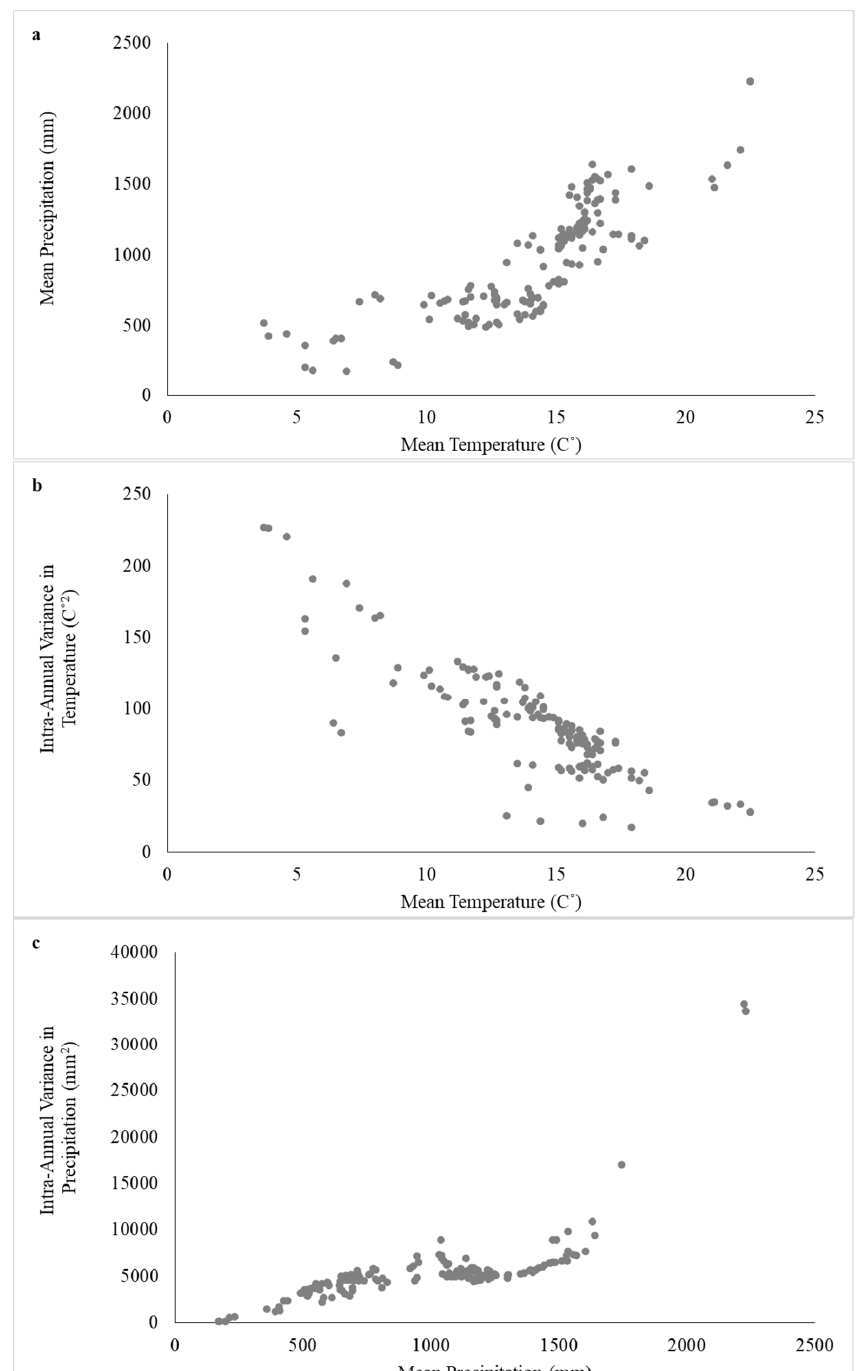
Figure 1. Relationship between historical climate variables in the dataset. ( a ) Annual average temperature and precipitation levels for each wastewater treatment plant in the sample; ( b ) Annual average temperature levels and intra-annual variation in temperature for each wastewater treatment plant in the sample; ( c ) Annual average precipitation levels and intra-annual variation in precipitation for each wastewater treatment plant in the sample.